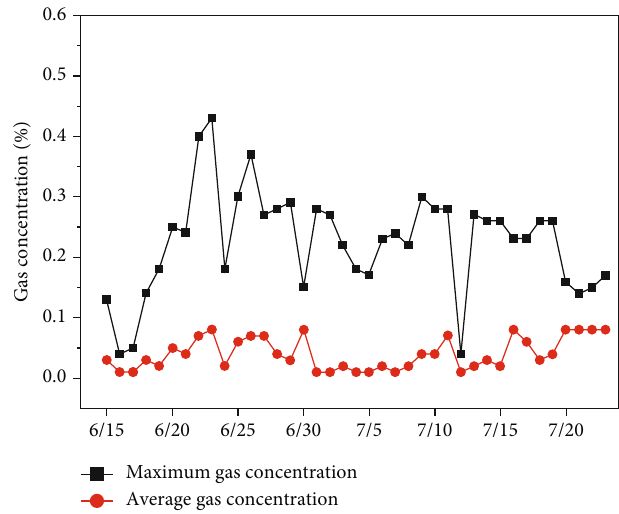
Figure 16: Curve of gas concentration in return air